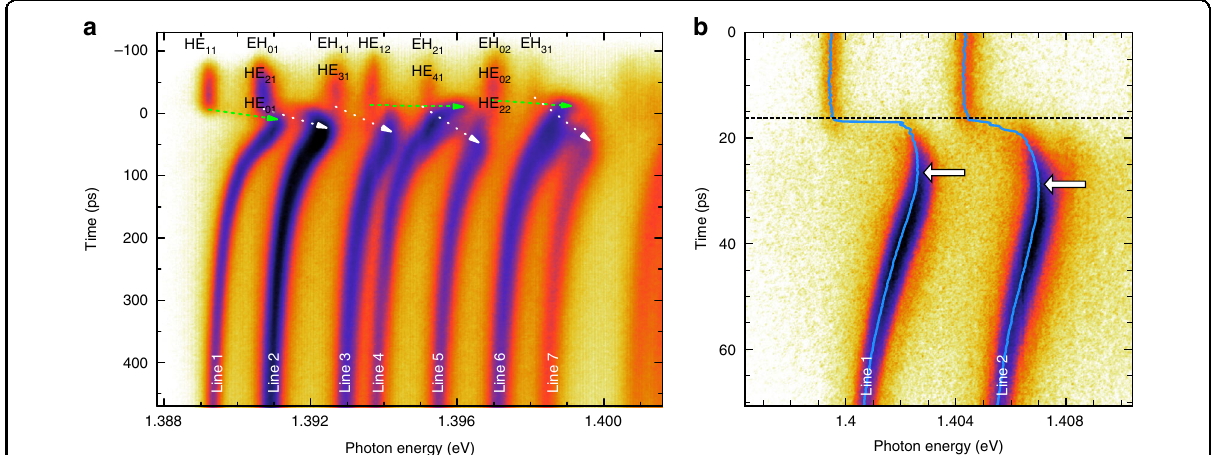
Fig. 1 Typical streak camera images obtained for two different QDMs and different operating time ranges for an on-axis pump beam. a A 500 ps-long time range enables capturing the entire switching event for the seven fi rst lines of a 5 µm diameter QDM (1.5 µm diameter pump centered on the pillar axis, pump photon energy E p = 1.57 eV, around 10 pJ/pulse). The arrows are guides to the eye, showing the shift of the lines during the switch-on event. The arrow ’ s tips point at the time-frequency point corresponding to the maximum line shift. The names of all pillar modes contributing to an emission line are indicated at the position of lines prior to the switch. b The two fi rst lines of a 3 µm diameter QDM are studied with a 2 ps resolution over a 70 ps-long time range (pump waist matched to the top facet of the QDM, E p = 1.55 eV, 7 pJ/pulse). The blue line represents the time-dependent position of the modes, deduced from Lorentzian fi ts of the PL spectrum at all times. The white arrows point at the maximum blue shift for each